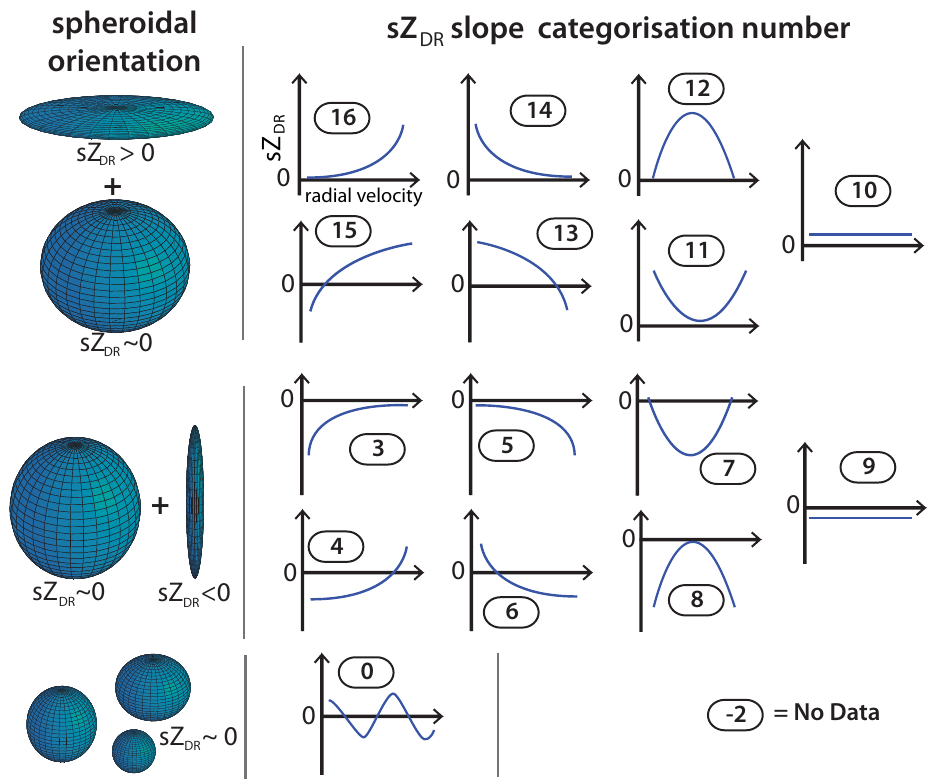
Fig. 8. sZ DR classification based on the slope and values of the spectra. 16 different sZ DR configurations are sorted out from cloud observations. On the left hand side, a spheroidal representation of the ice crystals shape(s) and orientation(s) contained in the same resolution volume is displayed for illustration, depending on the Doppler spectral